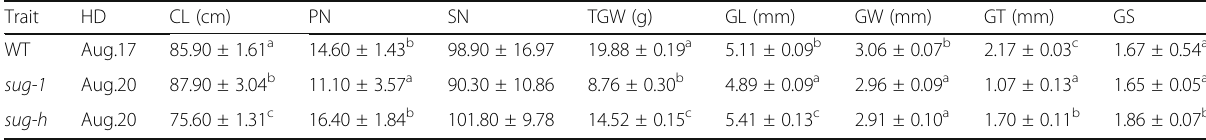
Table 1 Agronomical characters of plant and dimensions of grain in wild type (Hwacheong) and mutants Trait HD CL (cm) PN TGW (g) WT